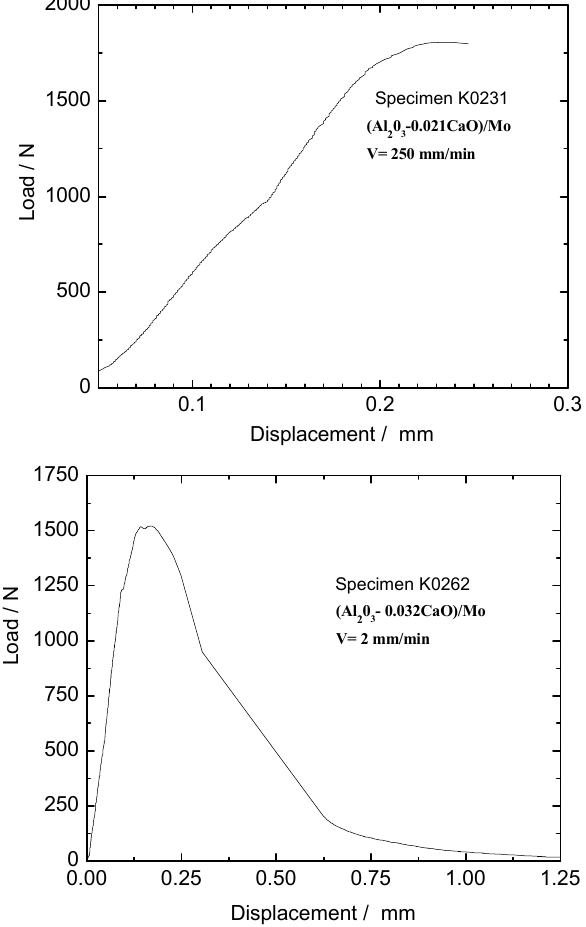
Figure 5. Typical load/displacement curves for composites with composite fibres. The fibre microstructures of specimens K0231 and K0262 are presented in Figures 2 and 3a,